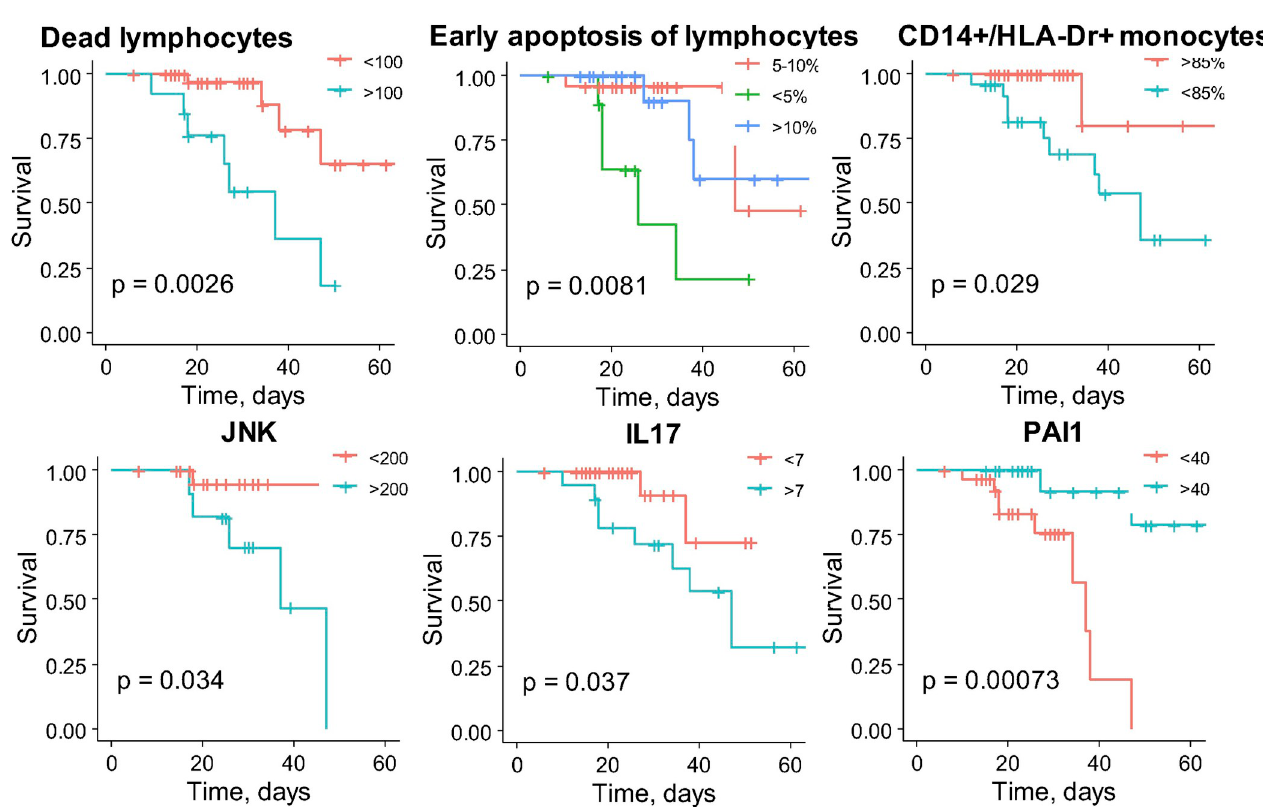
Fig 3. Kaplan-Meier survival curves for patients grouped by biochemical test parameters. The fraction of survival is expressed on the y-axis, while time (days) of the observation period is expressed on the x-axis. Vertical traits indicate censored data (hospital discharge). P values of log-rank tests are indicated for each graph. Reference group is shown in